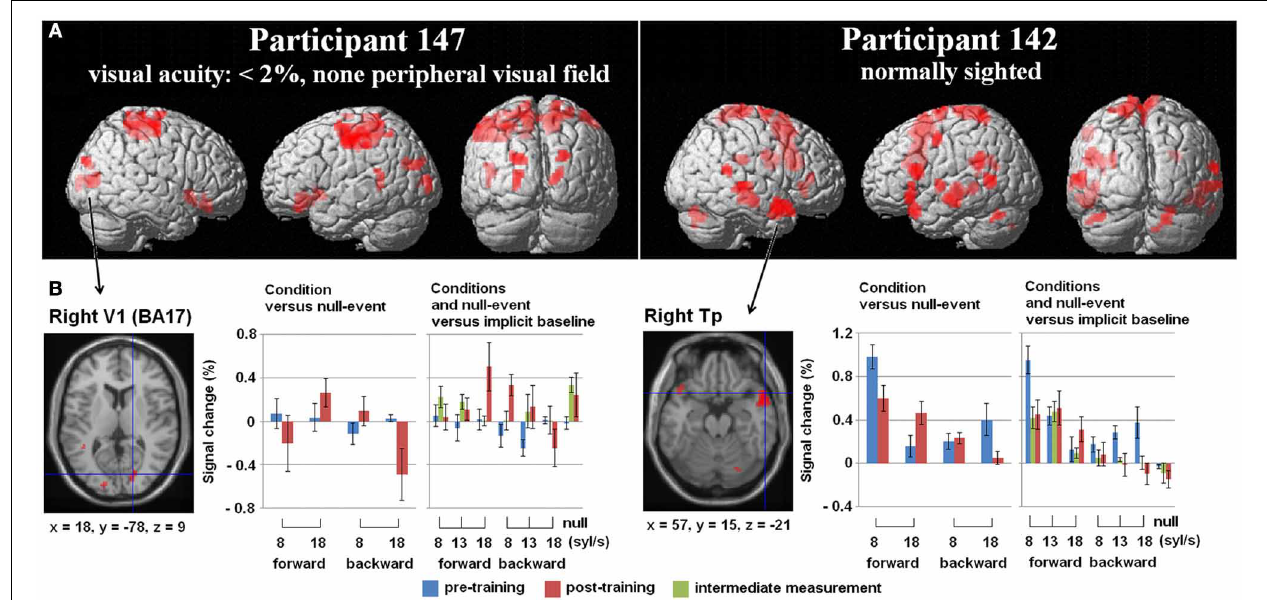
FIGURE 3 | (A) Three-Way interaction of an ANOVA (conditions vs. baseline), including the factors Mode (forward/backward speech), Speech rate (8/18syl/s), and Training (pre-/post-training) exemplified for two single subjects—the one with no residual vision and the normal sighted, both